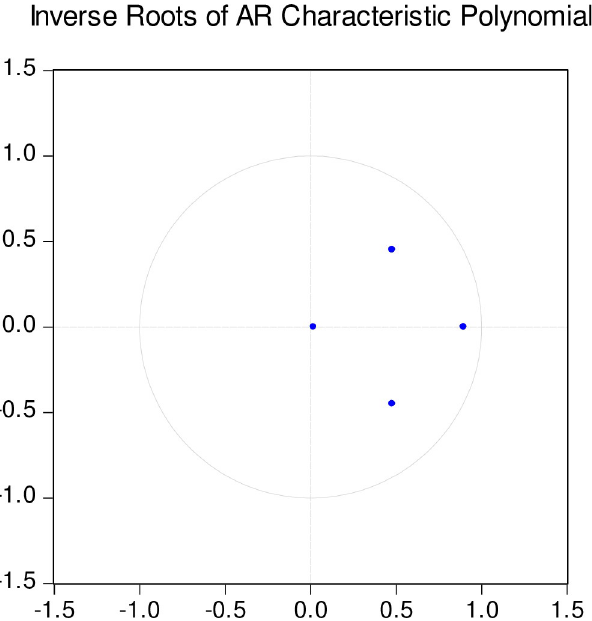
Fig 3. Inverse roots characteristic stability plot. Estimated in EViews 10. Inverse roots within the unit circle indicate stable estimates.